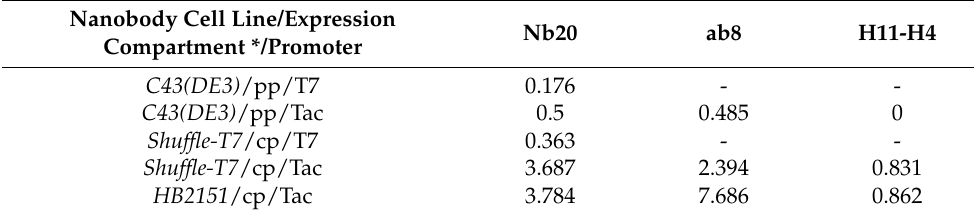
Table 1. Comparison of the expression yields (mg/L) by using different promoters (T7 and Tac) for the expressed Nb20 nanobody in C43(DE3) and Shuffle-T7 bacterial strains and comparison of the yields of the different nanobodies. Protein synthesis occurred predominantly either in the cytoplasm or periplasm by using different bacterial strains ( Shuffle-T7, C43(DE3), and HB2151 ) and the Tac promoter. * cp: cytoplasm; pp: periplasmic space.